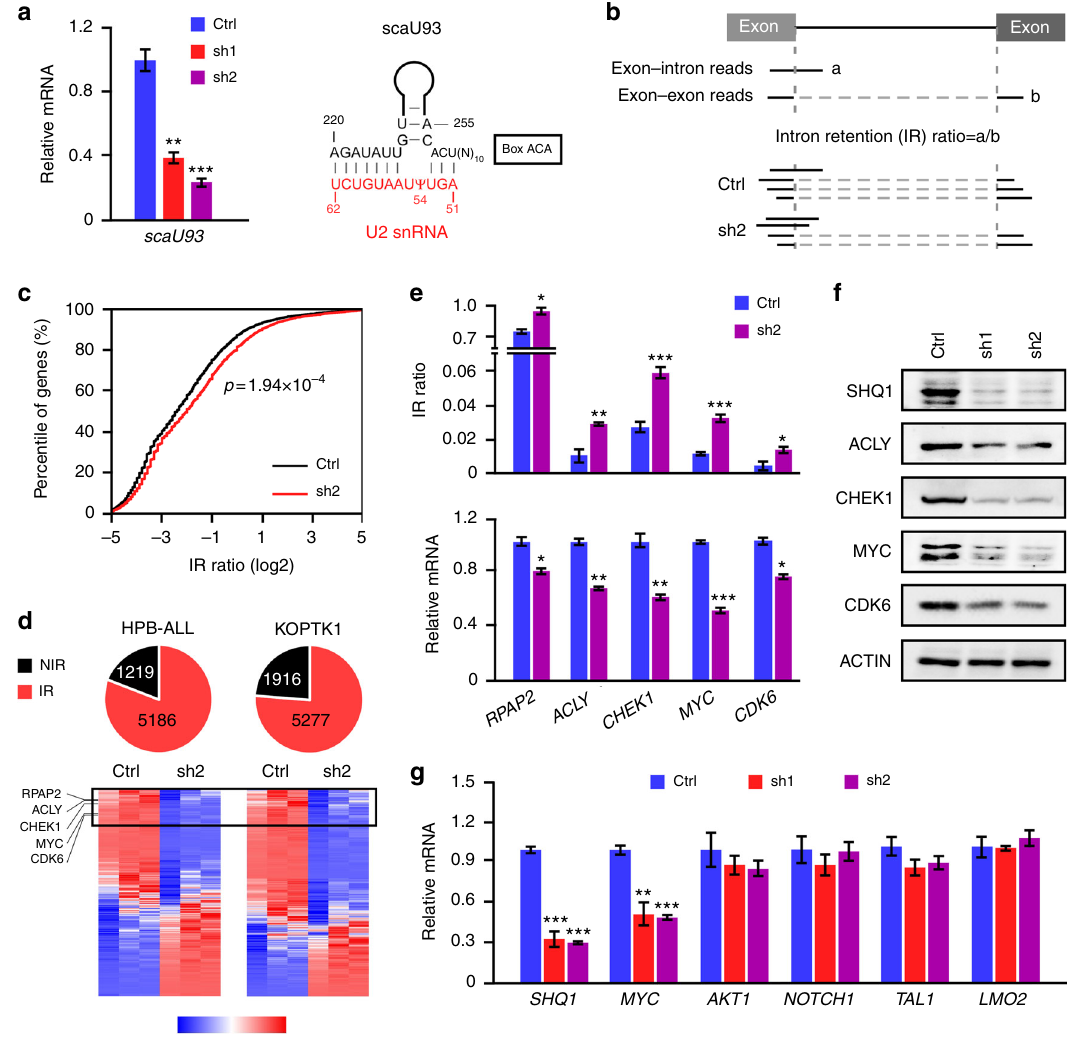
Fig. 6 SHQ1 depletion affects pre-mRNA splicing ef fi ciency. HPB-ALL or KOPTK1 cells were infected with lentiviruses expressing control shRNA (Ctrl) or SHQ1 shRNA (sh1 or sh2). a H/ACA snoRNA scaU93, base paired with U2 snRNA and guiding its pseudouridylation, in HPB-ALL cells expressing control shRNA (blue), SHQ1 shRNA-1(red), or shRNA-2(purple) was analyzed by qPCR. b Schematic of intron retention (IR) analysis. Exon – intron reads (a) relative to exon – exon reads (b) are de fi ned as IR ratio which re fl ects the magnitude of pre-mRNA accumulation. c Empirical cumulative distribution of IR coef fi cients for 6809 genes in HPB-ALL cells. Curves represent IR ratio in control (black) and shRNA-2 mediated SHQ1 depletion (red). A rightward shift in the curve representing SHQ1 -depleted cells indicates increased IR, namely increased pre-mRNA accumulation upon SHQ1 knockdown. d Genome-wide splicing and gene expression were analyzed in HPB-ALL and KOPTK1 cells. Numbers of genes with altered IR ratio were plotted in red at the pie chart, and those with no intron retention (NIR) were marked in black. Genes with IR ratios ( SHQ1 knockdown vs control) more than 1.15 are considered aberrant intron retention. Heatmaps of mature mRNA expression from intron-retained genes are presented at the bottom (red indicates increased and blue decreased). Top genes with most decreased mature mRNA associated with increased IR ratios in SHQ1 -de fi cient cells are highlighted in the box. e , f Validation of candidate genes shown in the box from d by assessing IR ratio, mature mRNA ( e ), and protein expression ( f ) in HPB-ALL cells. g Analysis of T-ALL associated oncogene expression in HPB-ALL cells by qPCR. In e and g , blue, red, or purple bars represent indicated RNA quanti fi cations in control shRNA, SHQ1 shRNA-1, or -2-expressing cells. Data shown represent the means (±SEM) of three biological replicates; * p < 0.05, ** p < 0.01, *** p < 0.001, unpaired t- test ( a , e , g ) or Kolmogorov – Smirnov test ( c